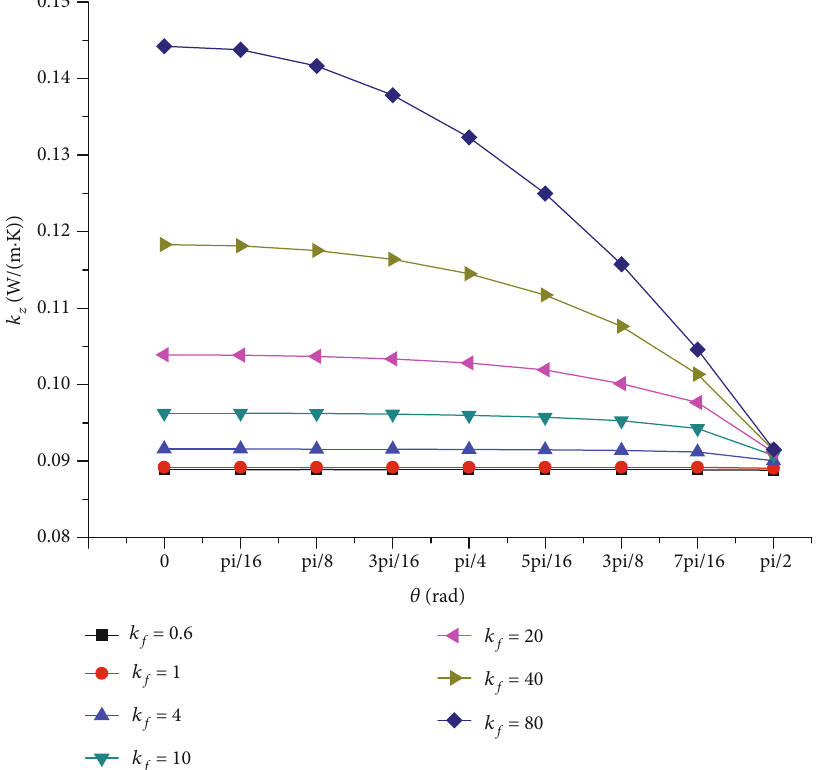
Figure 23: E ff ect of fi ber thermal conductivity and orientation angle on equivalent thermal conductivity.